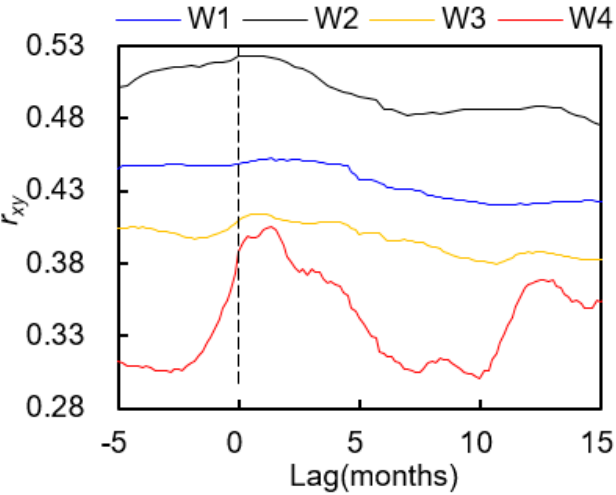
Figure 5. Cross-correlation diagrams between rainfall and GWLs.